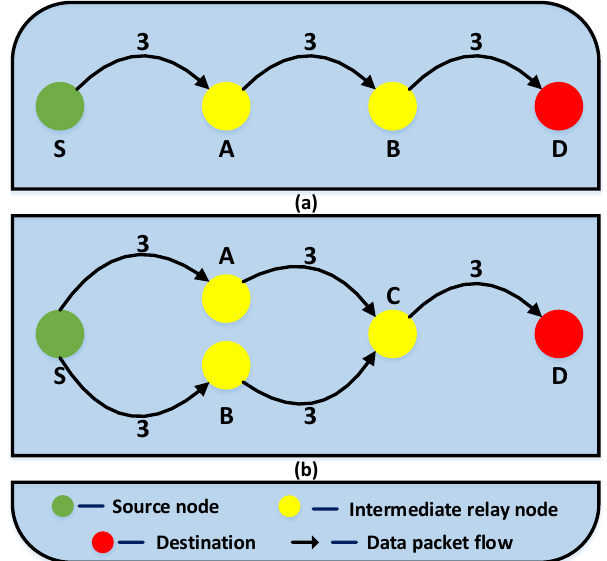
Figure 4. Illustration of data packet transmission scenario: ( a ) perfect unicast transmission and ( b ) data packet transmission with multiple relay nodes at single hop